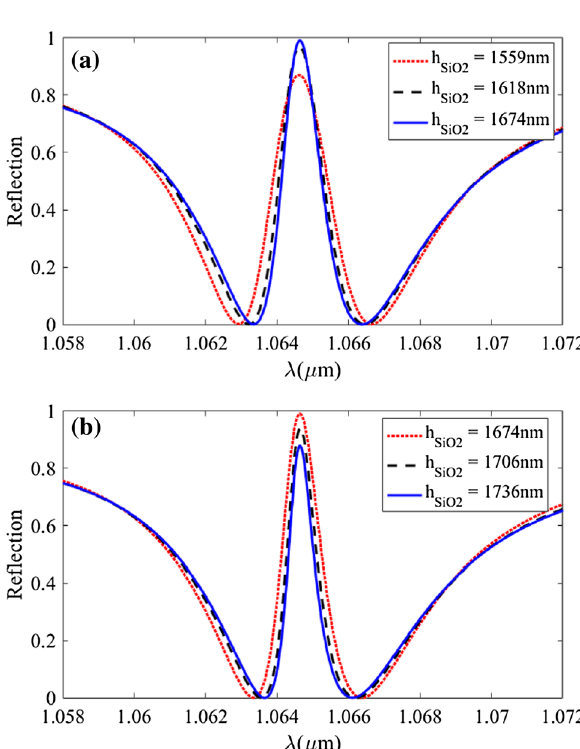
Figure 5. Effect of h SiO 2 on ( a ) Sensitivity, and d FOM, ( b ) Reflection and Q.